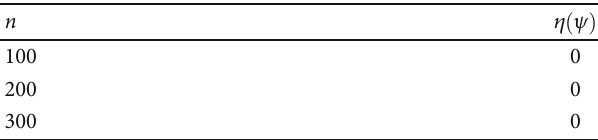
Table 1: Parameter of negativity for n = 100 , 200, and